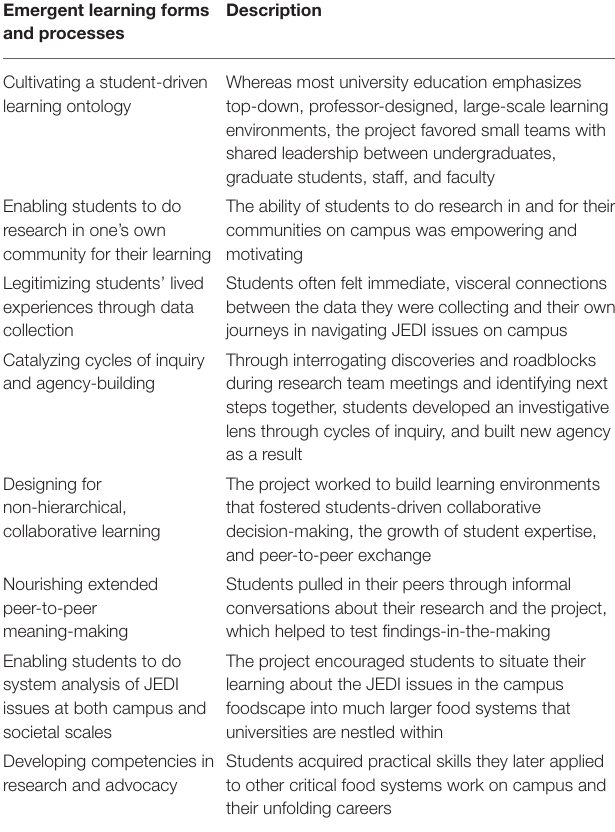
TABLE 3 | Emergent learning forms and processes. Emergent learning forms and processes